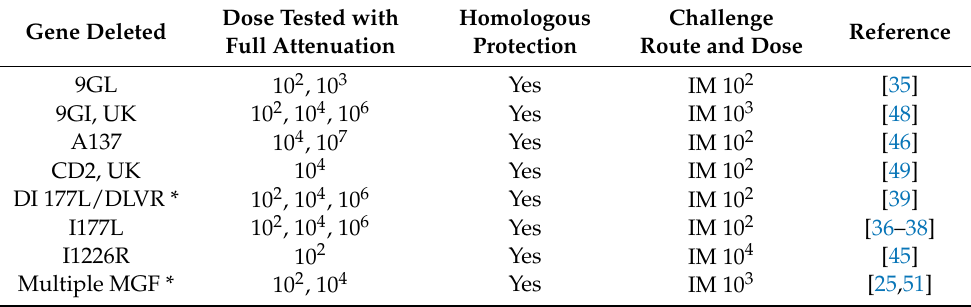
Table 5. Genetic deletions in ASFV-Georgia viruses resulting in experimental vaccines. Gene